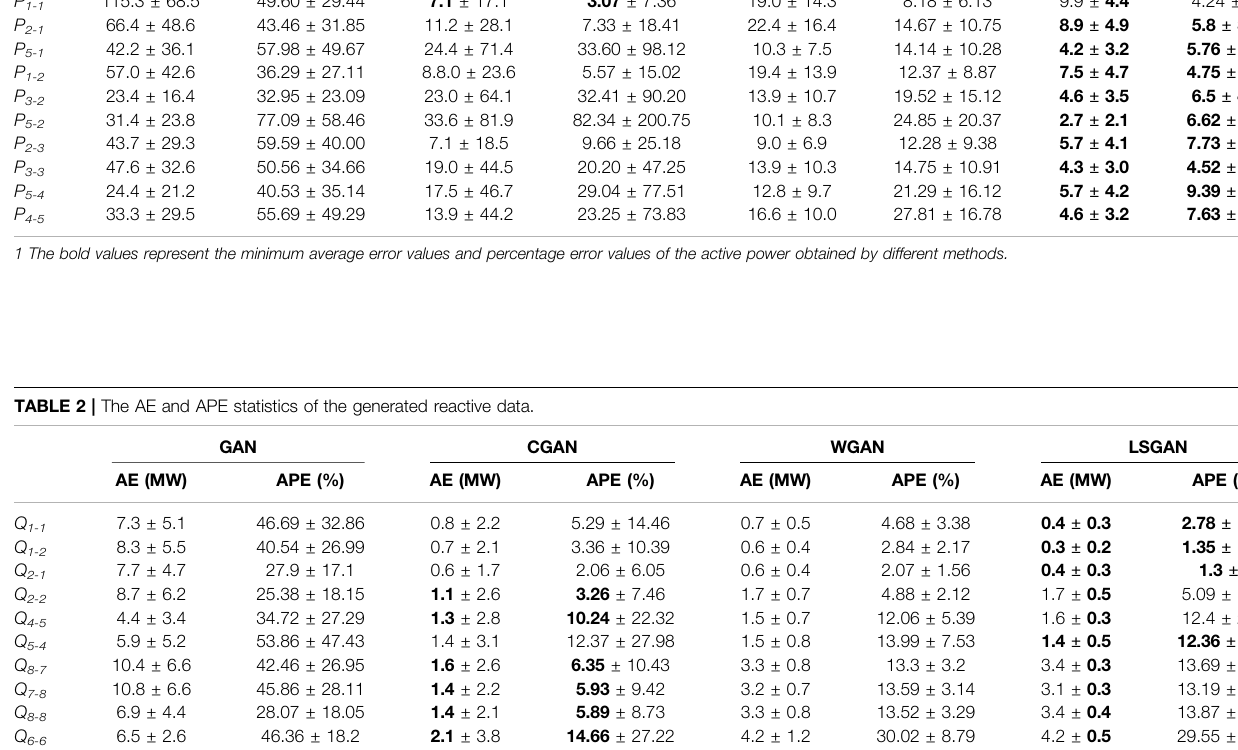
TABLE 1 | The AE and APE statistics of the generated active data. GAN CGAN WGAN